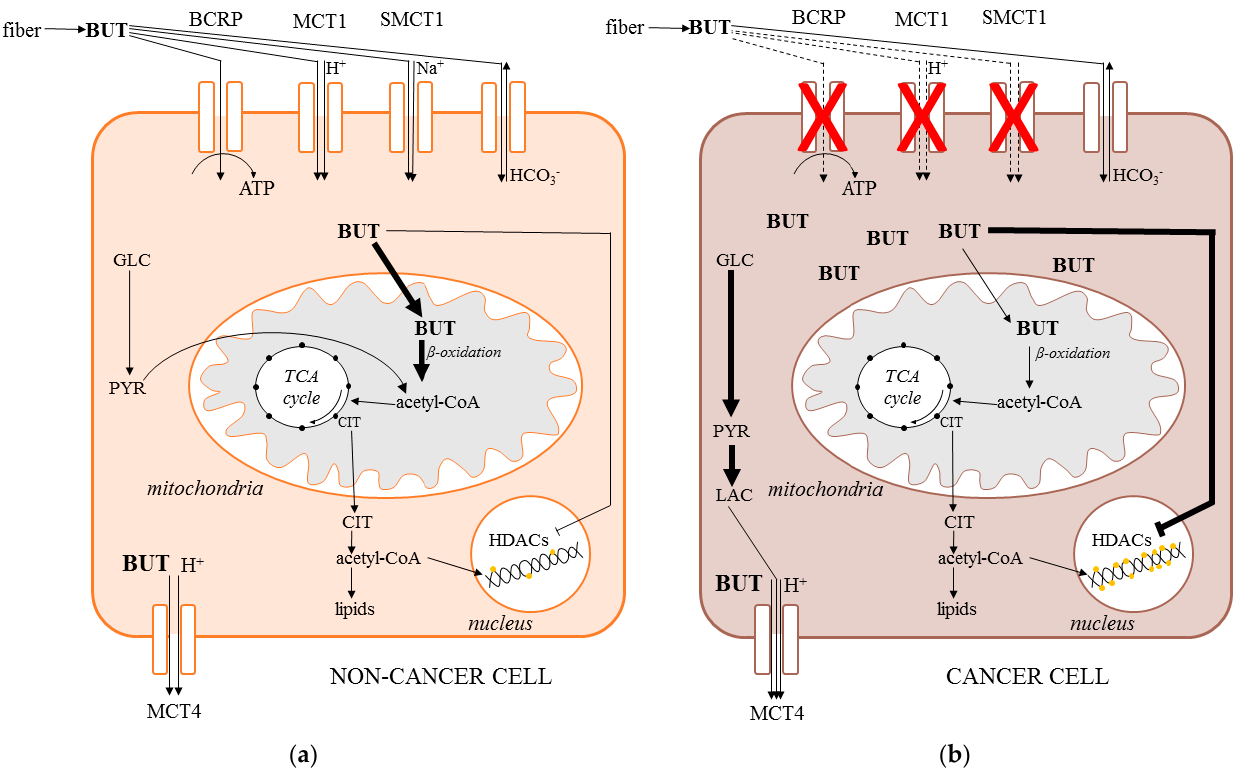
Figure 2. Import and metabolism of butyrate in non ‐ cancer ( a ) and cancer cell ( b ) (BCRP—breast cancer resistance protein, BUT—butyrate, CIT—citrate, HDACs—histone deacetylases, MCT—monocarboxylate transporter, GLC—glucose, LAC—lactate, PYR—pyruvate, TCA—tricarboxylic acid cycle).